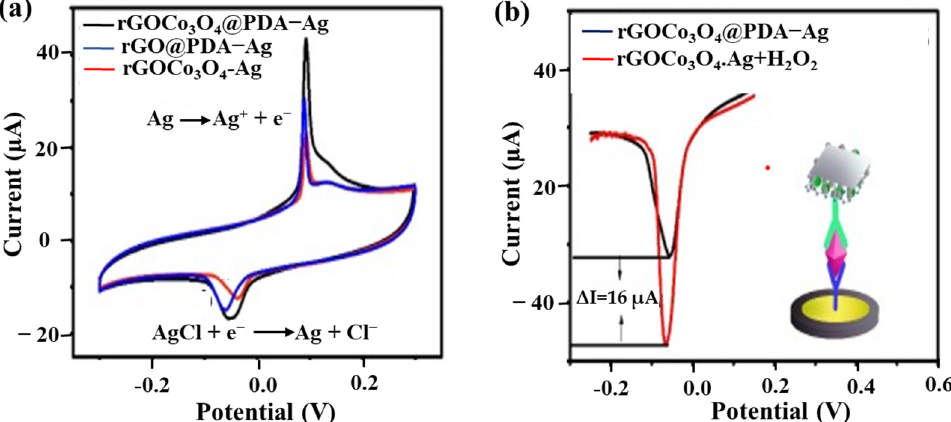
Figure 6. An example of using soluble AgNPs-based nanocomposite as a label for CEA detection. ( a ) CVs of RGO/Co 3 O 4 -Ag, RGO@PDA-Ag, and RGO/Co 3 O 4 @PDA-Ag in 0.1 M PBS (pH = 7.0) containing 0.1 M KCl. ( b ) DPV of RGO/Co 3 O 4 @PDA-Ag in 0.1 M pH 7.0 PBS containing 0.1 M KCl with (red line) or without (black line) 3 mM H 2 O 2 . Redrawn from [49].© Elsevier publishing.